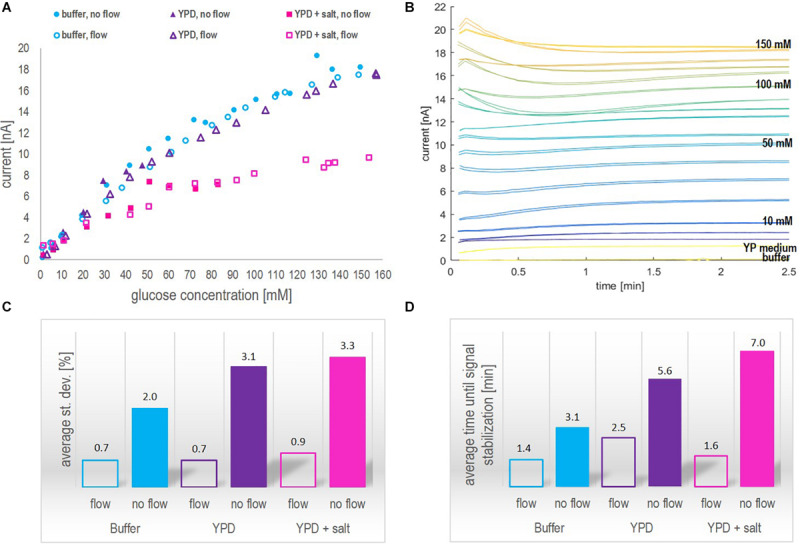
(A) Steady-state current in nA as a function of the glucose concentration in mM obtained in the different media applying the biosensor platform under dynamic (flow of 0.2 ml/min) and static (no-flow) operation. (B) Raw signal development (current in nA as a function of time in min) obtained for different glucose concentrations in YP medium under dynamic operation. The lowest current curve (yellow) was obtained in buffer, followed by the response obtained in YP medium and at different glucose concentrations starting from 1 mM, over 5 mM to 10 mM. The steps between the indicated concentration values of 10 mM, 50 mM, 100 mM and 150 mM are 10 mM. (C) Average standard deviation in % per data point of glucose concentrations measured with the biosensor platform (internal duplicate) in the three media under investigation. (D) Average time until signal stabilization of biosensor measurements in min in the three media under investigation.